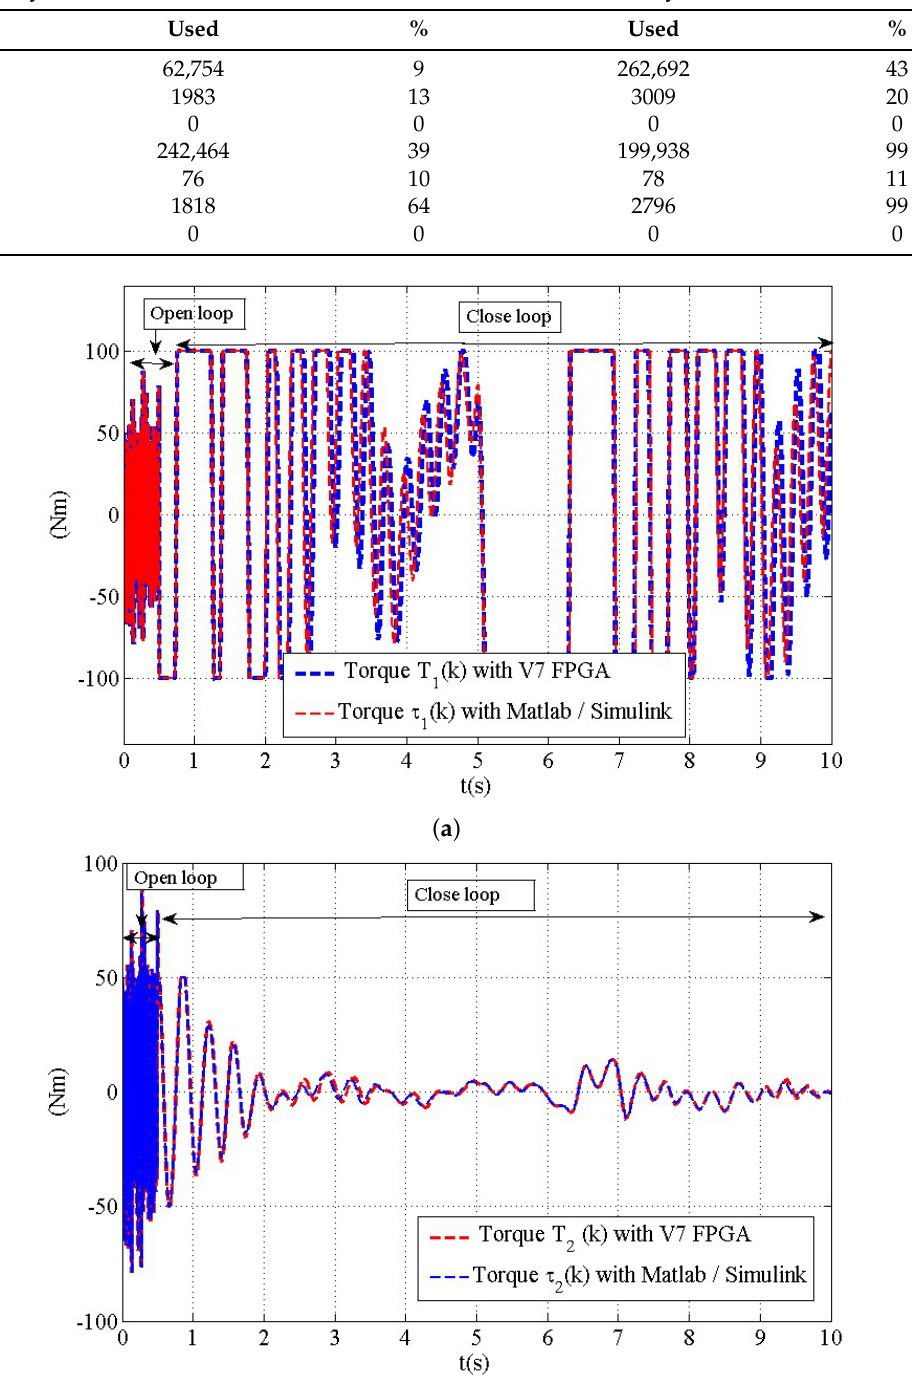
Figure 8. Applied torque for ( a ) joint 1 and ( b ) joint 2.